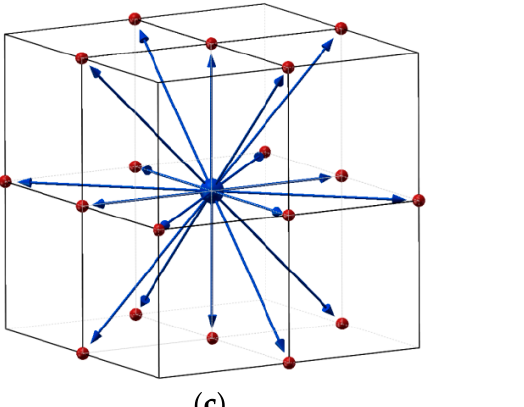
Energies 2021 , 14 , x FOR PEER REVIEW 6 of 37